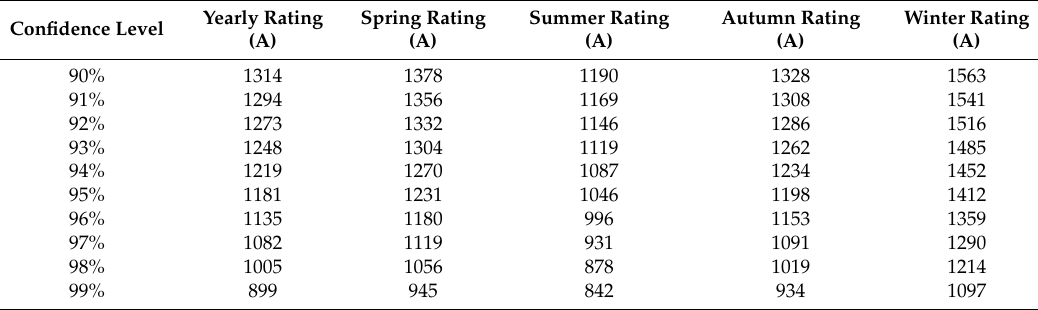
Table 3. Yearly and seasonally ratings under different confidence levels.